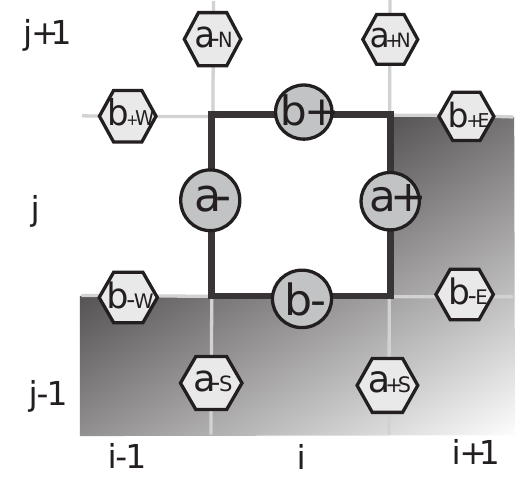
Fig. 7: Stencil for the SSA boundary condition in the case of an ice-filled (white) cell with ice-filled and ice-free (shaded) neighbors. For this specific shape of the calving front the boundary indicators a − ,b + and a − N ,a + N ,b + W have the value 1, whereas a + ,b − and a − S , a + S ,b − W ,b − E ,b + E have value 0.